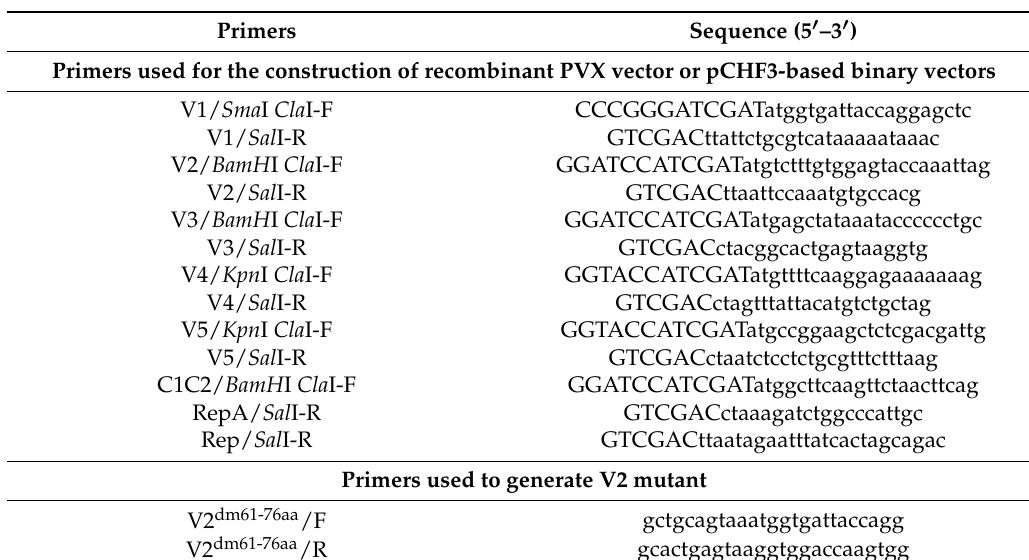
Table 1. Synthetic oligonucleotide primers used in this study. Primers Sequence (5 (cid:48) –3 (cid:48)